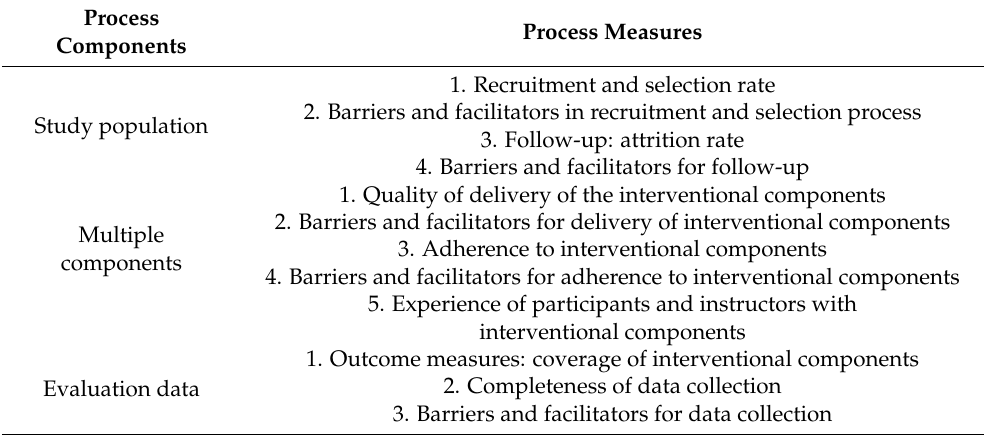
Table 2. Process-evaluation components and related process measures of a complex